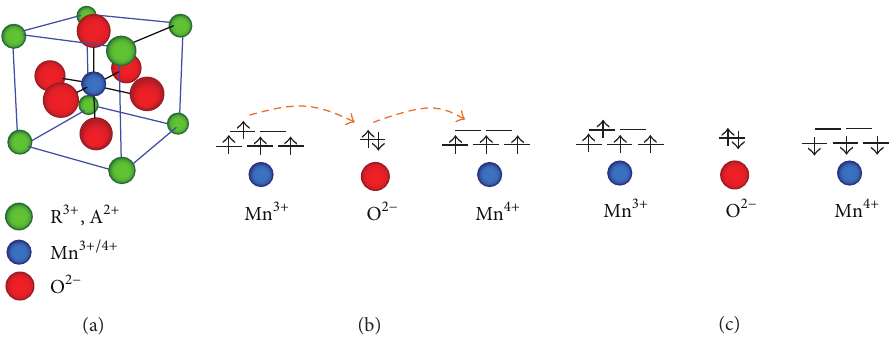
Figure 3: Schematic diagrams of (a) ideal cubic structure of perovskite manganite and the double exchange of (b) ferromagnetically and (c) antiferromagnetically aligned Mn-O-Mn